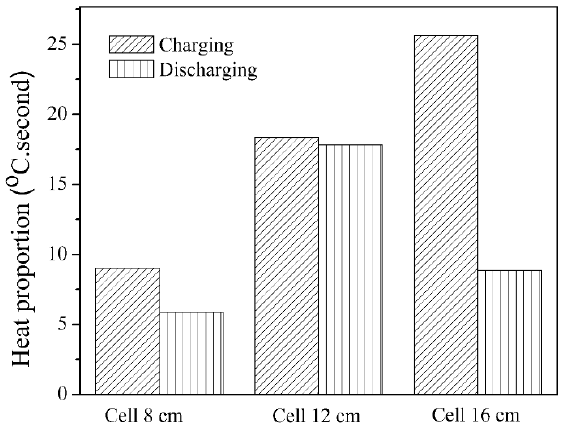
Figure 7. The estimated heat exchanges of co_oil cells, consisting of charging and discharging capability for three different cell sizes.